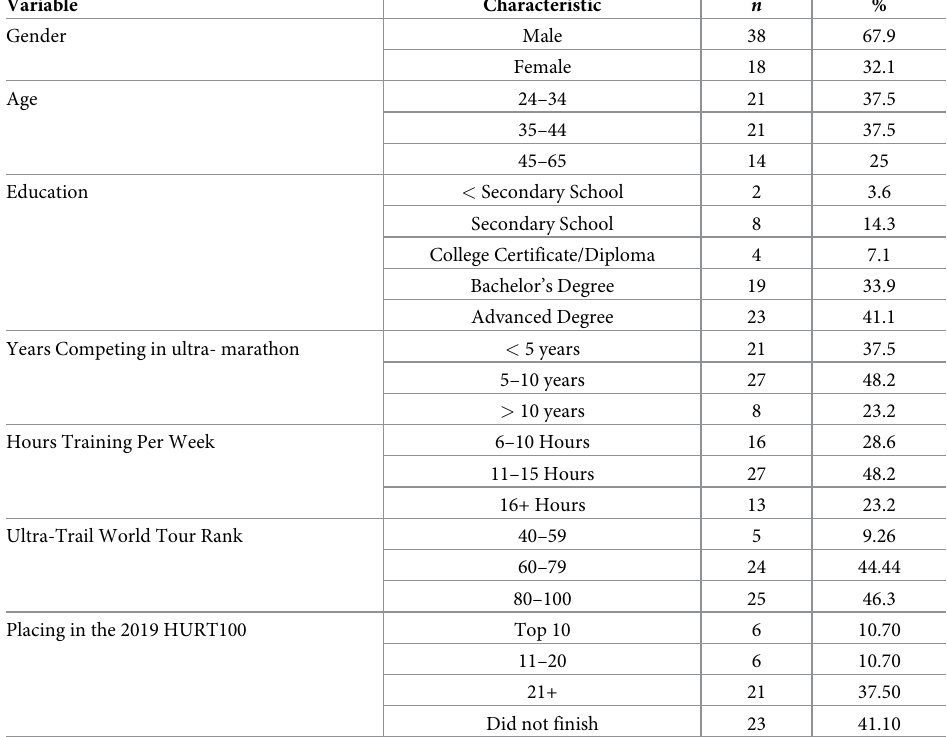
Table 1. Characteristics of Ultra-Marathon runners